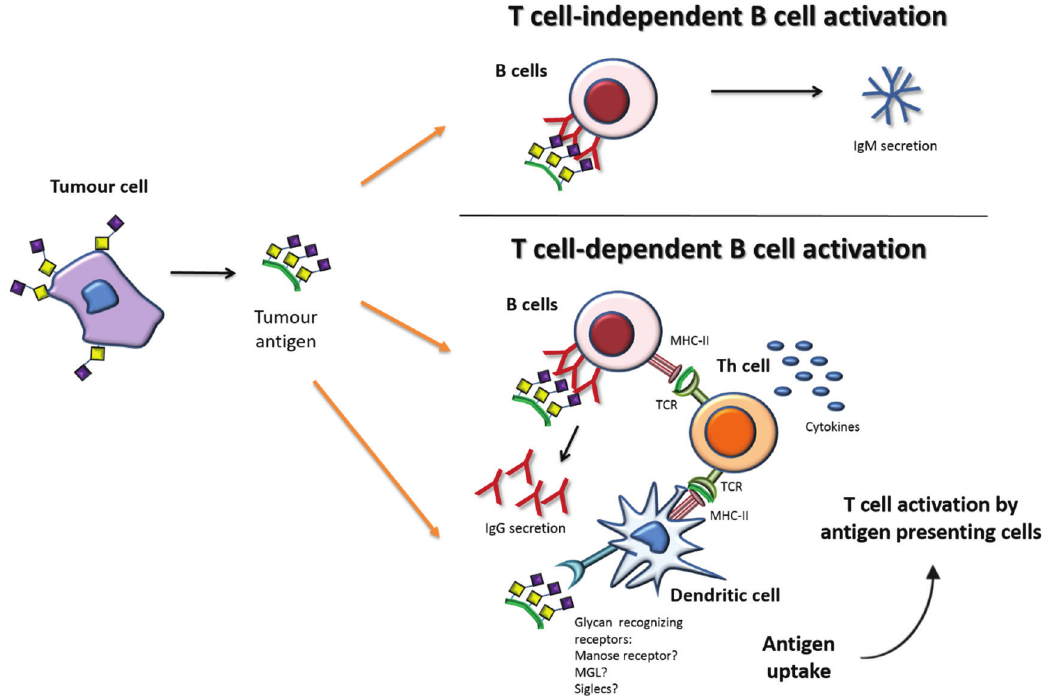
Figure 2. Simplified depiction of tumor antigen recognition and the induction of humoral immune responses. Upper panel—Glycan antigens can be directly recognized by B cells and the cross-linking of the B cell receptors lead to IgM secretion through T cell-independent B cell activation. Lower panel—Tumor antigens can be endocytosed by antigen presenting cells, such as dendritic cells, or B cells and then presented to helper T cells (Th) cells thus leading to T cell activation and subsequent T cell-dependent B cell activation. Adapted from